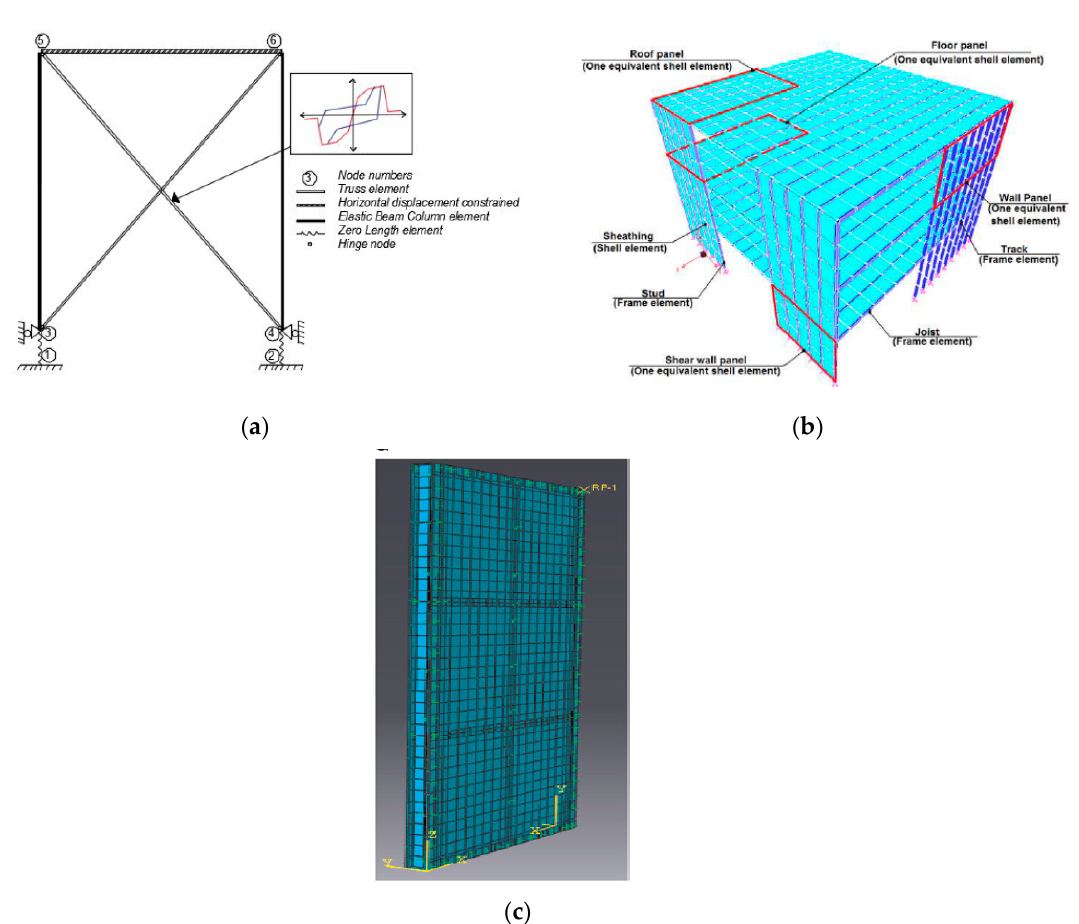
Table 2. Examples of classification of non-structural components based on the sensitive to the seismic actions.